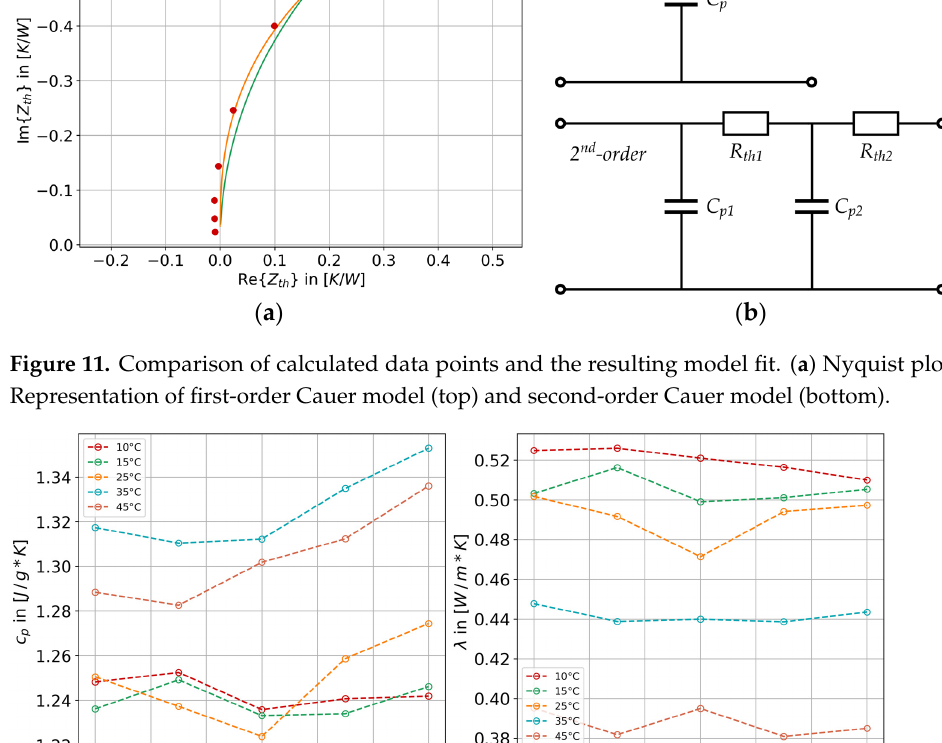
Figure 12. Changing of thermal parameters over SOC range for all covered temperatures. ( a ) Specific heat capacity c p . ( b ) Cross ‐ plane thermal conductivity λ ⊥ .